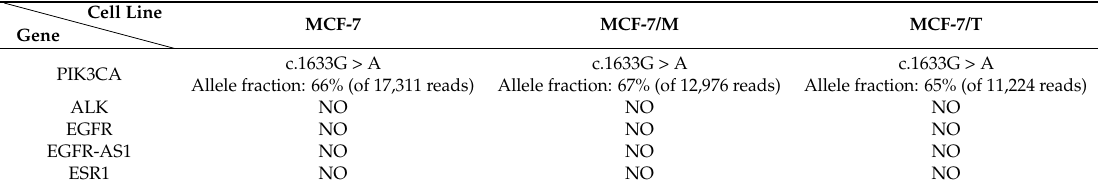
Figure 1 . The characteristics of the resistant cell sublines. Cell sensitivity to tamoxifen and metformin. The cells were treated with 5 μM SERM tamoxifen or 10 mM biguanide metformin for 3 days and the amount of the viable cells was assessed by the MTT-test. Data represent mean value ± S.D. of three independent experiments. 100% was set as the viability of cells treated with vehicle control. Table 1. Coding mutations in MCF-7, MCF-7/M and MCF-7/T cells.